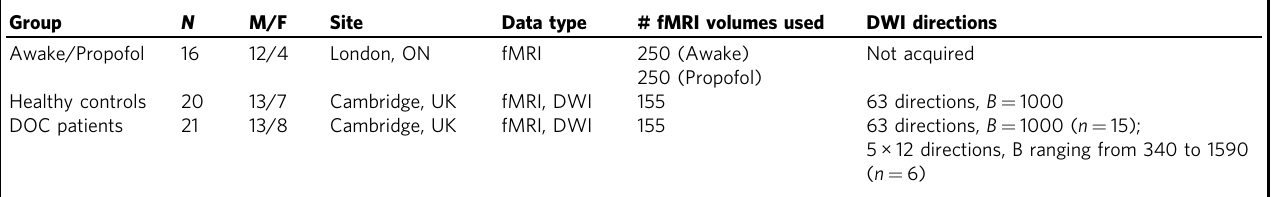
Awake and propofol data were acquired from the same subjects, respectively before and after infusion with the anaesthetic. For the DOC patients, 300 volumes were acquired in total, but to ensure consistency with controls we only used 155 consecutive volumes from each patient. Note that no direct comparisons were performed between data acquired in London, ON and data acquired in Cambridge, image acquisition schemes were used. For the fi rst acquisition scheme, we collected 5 sets of 12 non-collinear diffusion-sensitising gradient directions, each set using a different b-value (5 b-values in total) ranging from 340 to 1590 s/mm 2 ; therefore, a total of 60 diffusion-weighted volumes were acquired for each patient with this